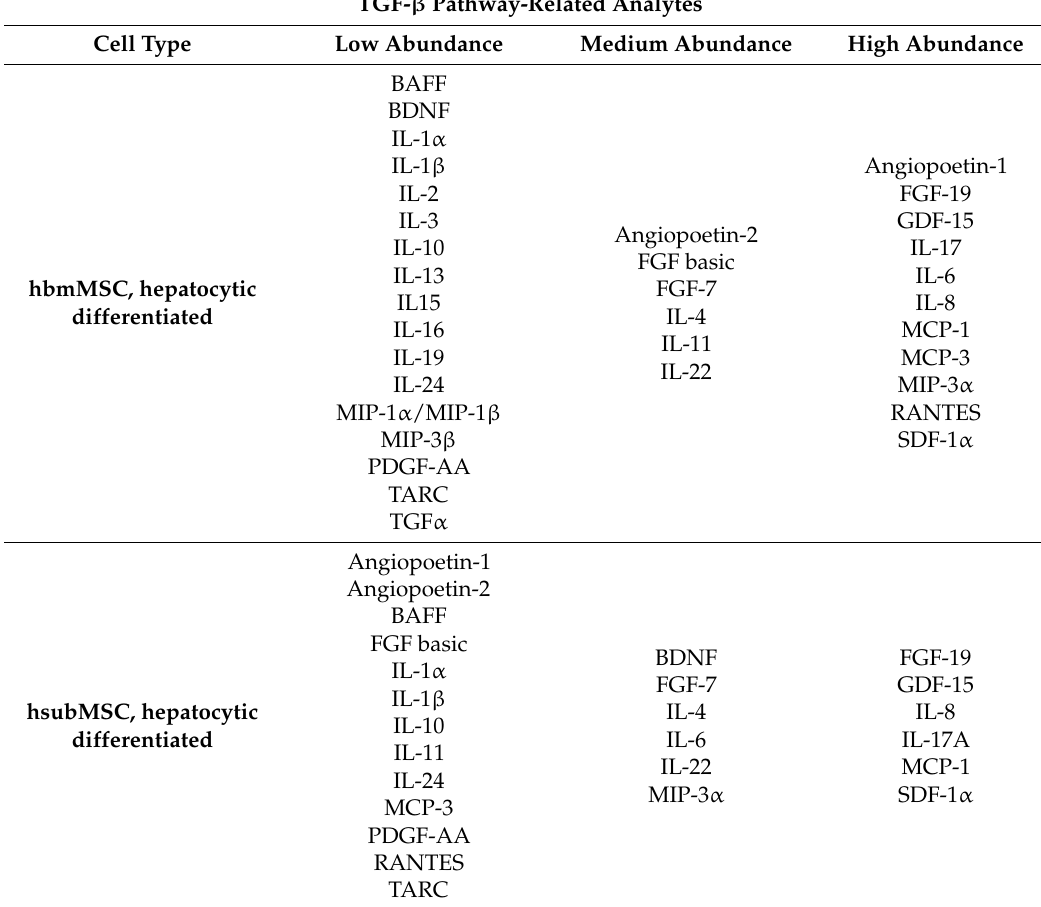
Table 5. Analytes secreted by hepatocytic differentiated hbm- and hsub-MSC in association with the TGF- β Pathway Super Path as identified by the PathCards pathway unification